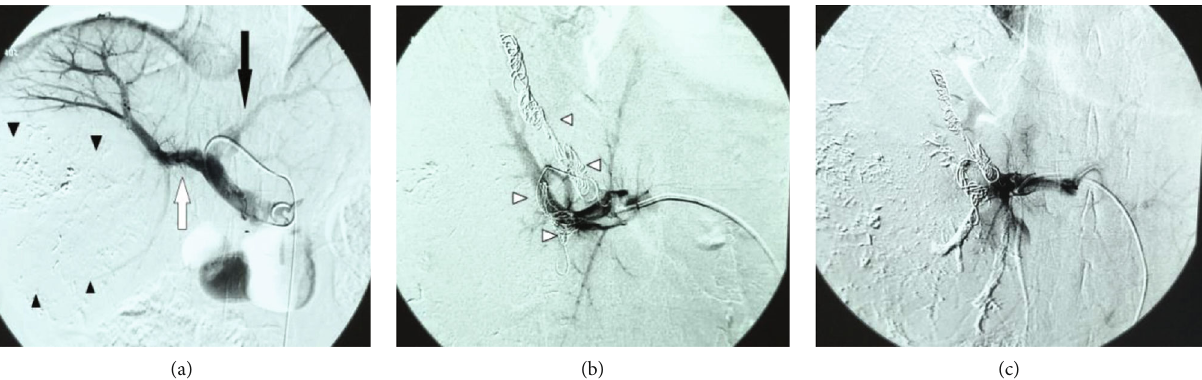
Figure 5: (a) Portal venogram showing the right portal vein (white arrow), the left portal vein (black arrow), and the HCC (black arrowheads). (b) Coils in the anterior and posterior branches of the right portal vein (white arrowheads). (c) Final portal venogram shows occlusion of the right portal vein